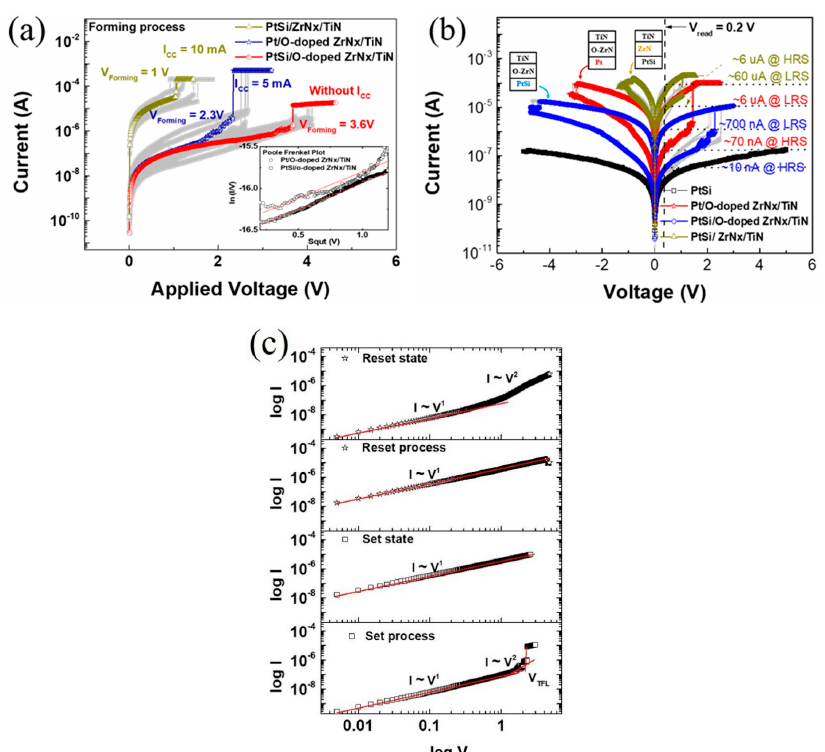
Figure 2. ( a ) Forming process and ( b ) resistive switching characteristics in current-voltage curve characteristics at room temperature for the PtSi, Pt/O-doped ZrN/TiN, PtSi/O-doped ZrN/TiN and PtSi/ZrN/TiN samples. Inset of Figure 2a shows P–F fitting with ln (I/V) vs. sqrt (V) for forming curves and ( c ) SCLC fitting with log-log scales in I–V curves.